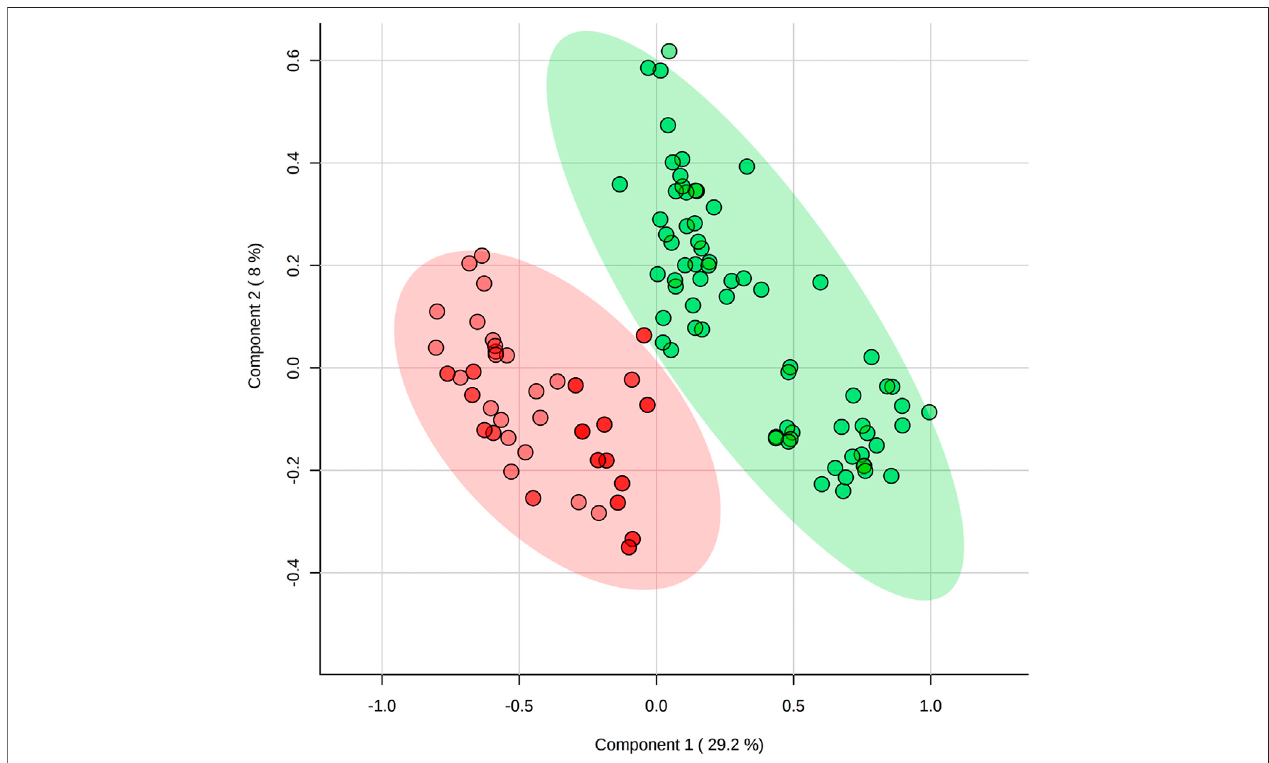
FIGURE4| Comparison ofpost-gamemetabolomes(metabolic pro fi le)betweenbackcourt and frontcourt players duringelitemale basketballgamesusing partial least square discriminant analysis. Red: backcourt, green: frontcourt.